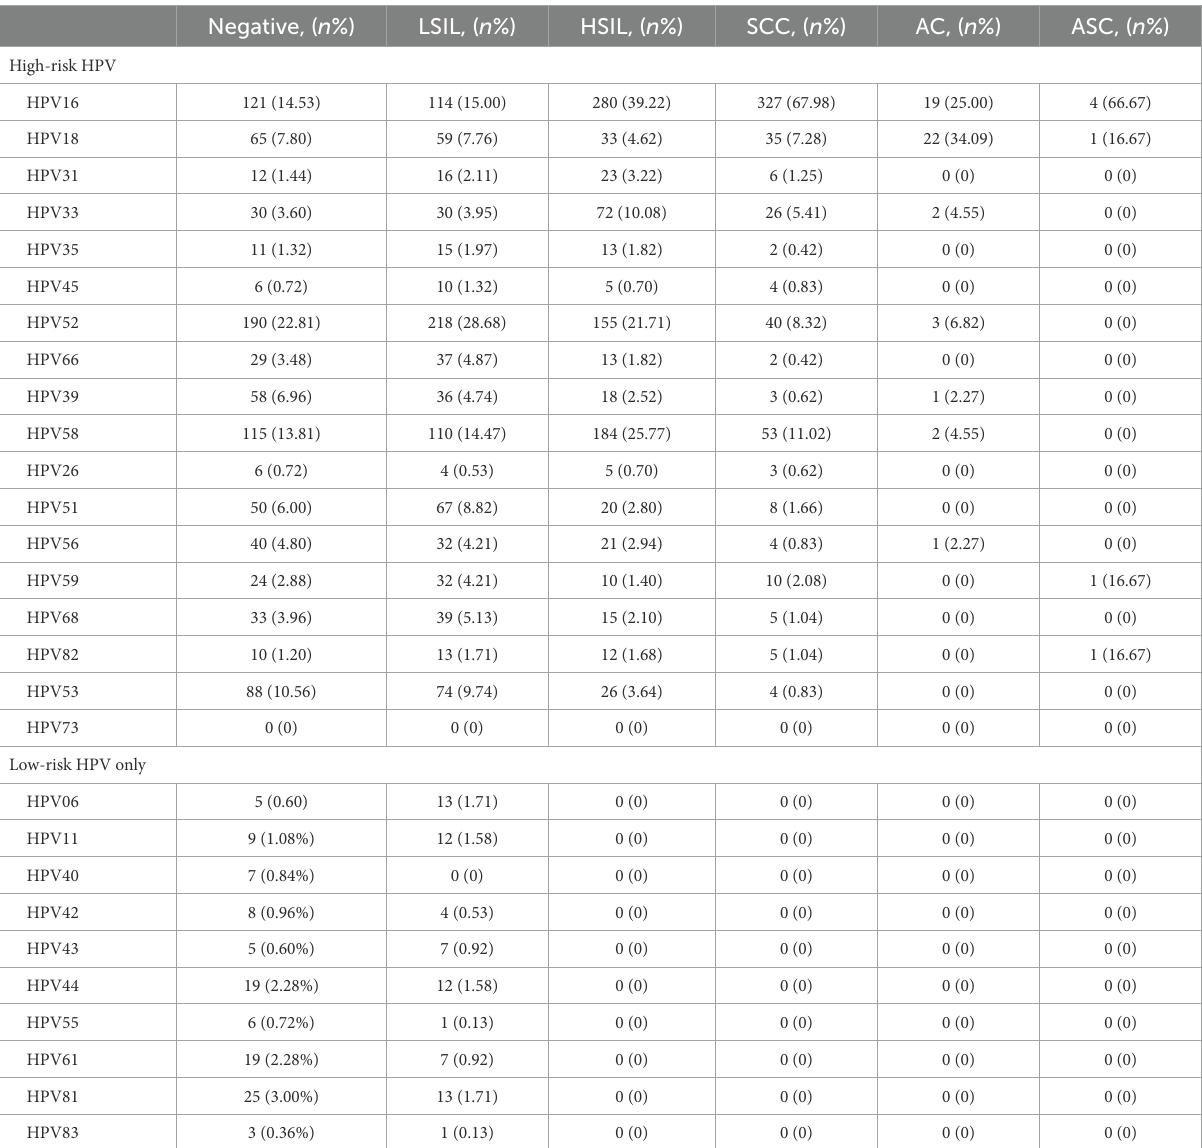
TABLE 5 Distribution of HPV genotypes in different pathological